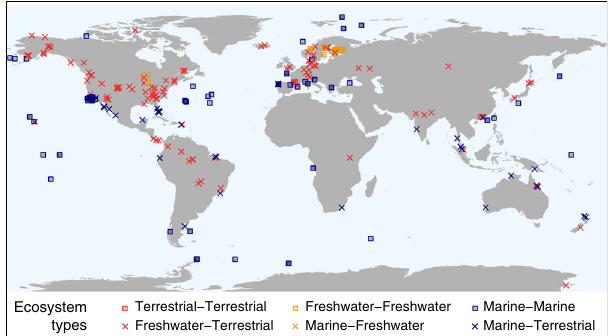
Fig. 1 Global distribution of quanti fi cations of cross-ecosystem fl ows of carbon. Colors and shapes indicate the type of ecosystems coupled by cross-ecosystem fl ows of carbon: terrestrial (i.e., forest, grassland, agro- ecosystem, desert), marine (i.e., ocean pelagic, ocean benthic) and freshwater (i.e., stream, lake, wetland). The map is made with Natural Earth. Free vector and raster map data @